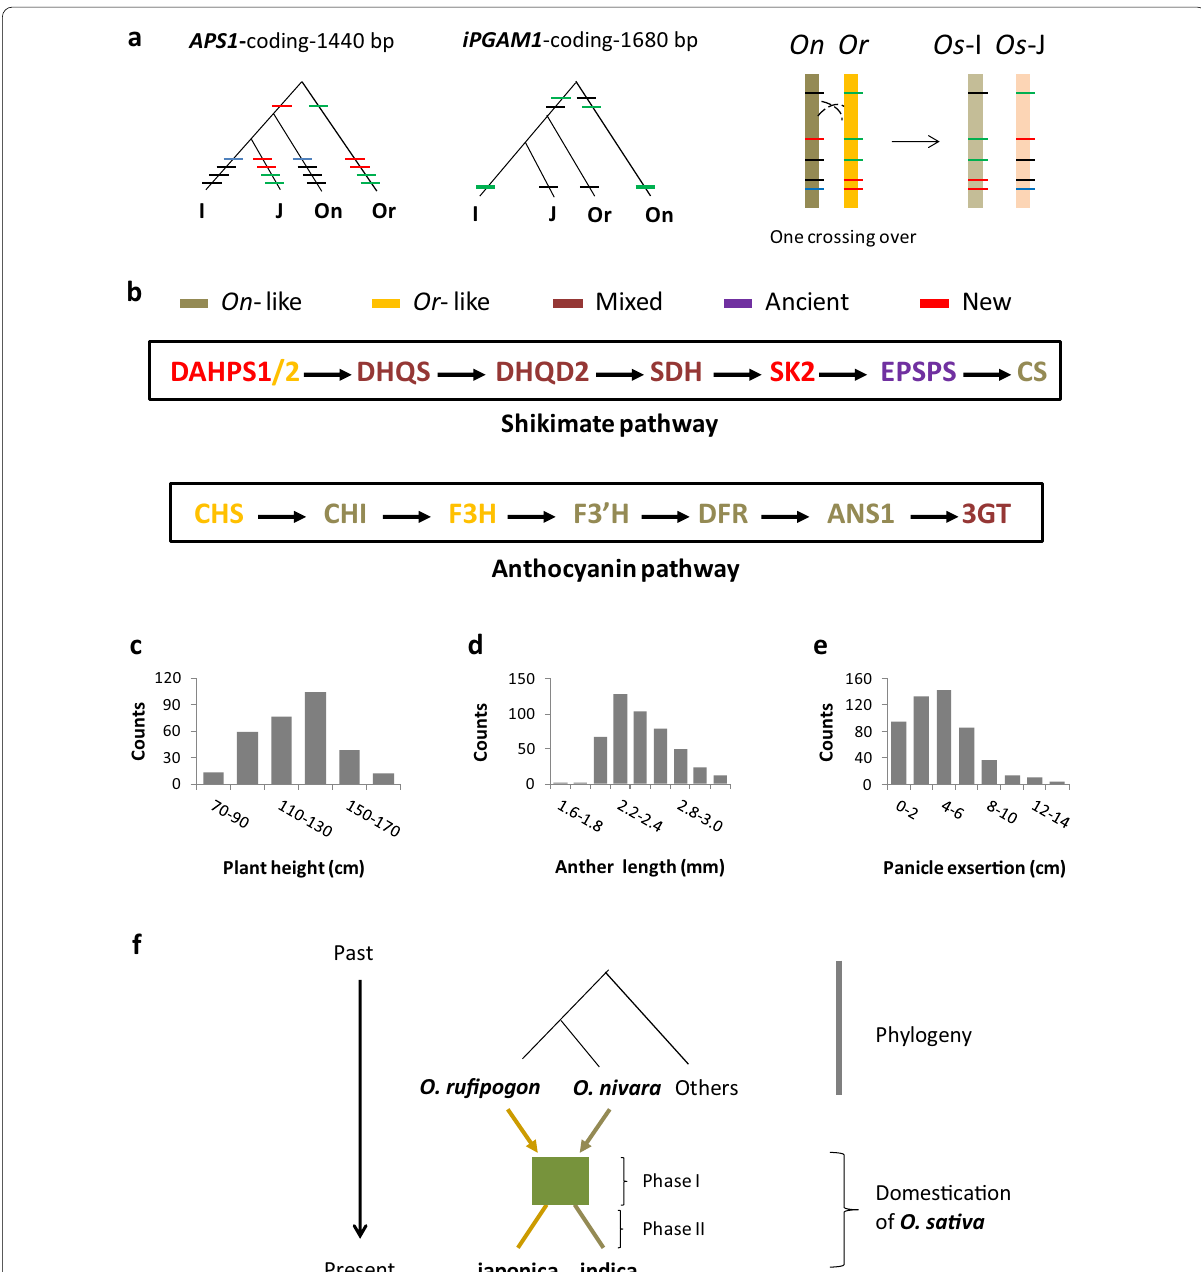
Fig. 4 The hybrid origin of O. sativa . a Gene genealogies showing two recombinant alleles identified in O. sativa. One is japonica allele at OsAPS1 , and the other indica allele at iPGAM1 . Both can be generated by one crossing-over event during synapsis between chromatids of parental genomes O. rufipogon ( Or ) and O. nivara ( On ), as shown to the right. b Origins of structural genes of two metabolic pathways in rice. c The distribution of plant height in O . sativa . Plant height was measured at harvest on F2 progeny (N 305) of a cross between Heidao as pollen receiver and Jixuenuo = as pollen donor. See Additional file 6: Data 1 for detail. d Variation of the anther length just before dispersal of pollen. A total of 65 plants from the F2 population, one japonica , and three indica cultivars were sampled in two days at noon when flowers (N 466) were open. See Additional file 7: = Data 2 for detail. e Degree of panicle exsertion in O . sativa . A random sample of 232 plants from 46 accessions of indica, japonica, and their crossed progeny were measured at 696 panicles for stem length beyond the sheath of flag leaf. Details see Additional file 7: Data 2. f A brief summary of rice domestication. The green rectangle indicates the period when rice was selected as one crop. The colored arrows show contributions of parental genomes, and the bar of the same color indicates slight more contribution of the species to the subgroup. The dots represent other